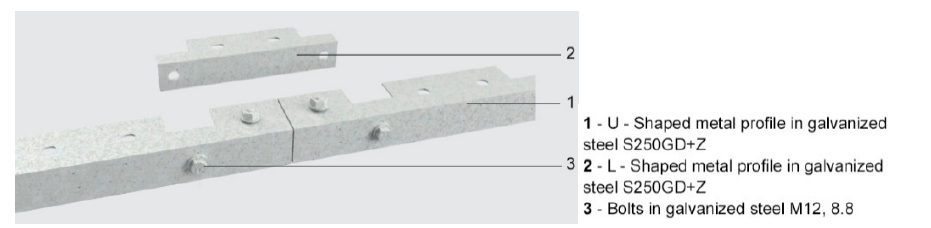
Figure 2. Anchoring system to the masonry structure.